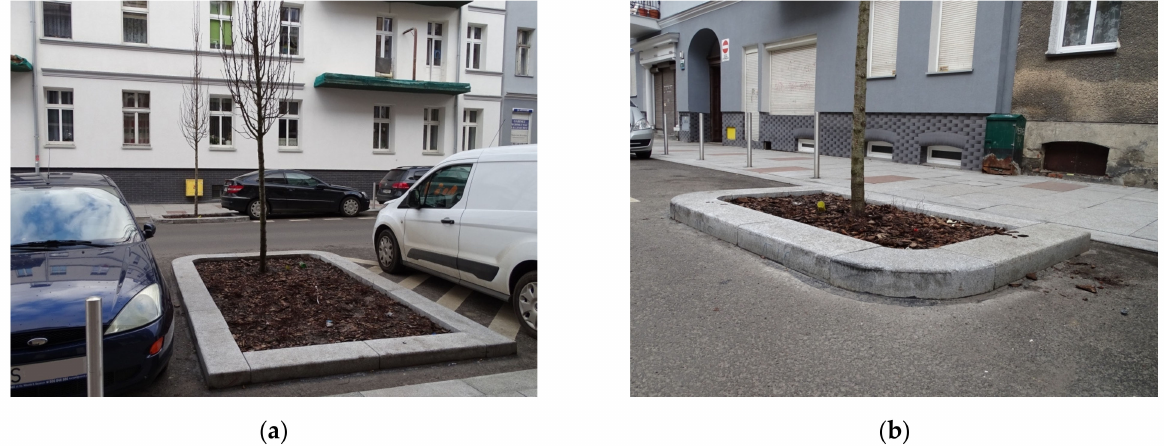
Figure 2. Bollards limiting the parking spaces and greens planted on the carriageway between the parking spaces: ( a ) on on-street perpendicular parking lanes; ( b) on on-street parallel parking lanes. Source: own work of the